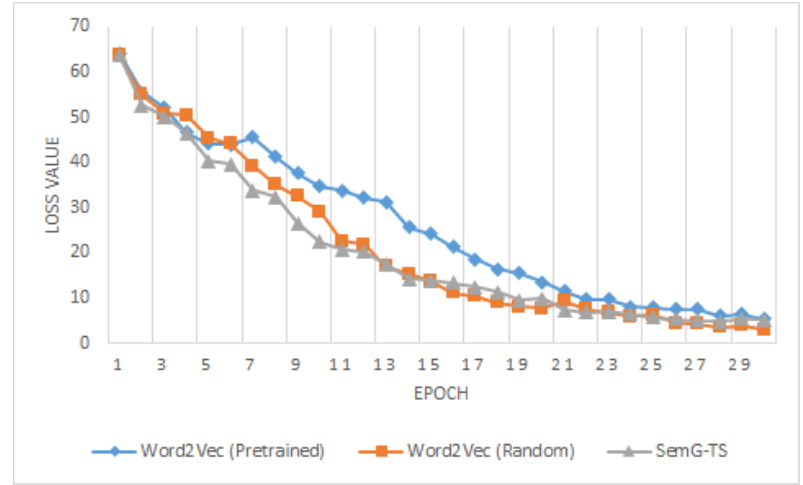
Figure 5. Loss values for experiment with 30 epochs.